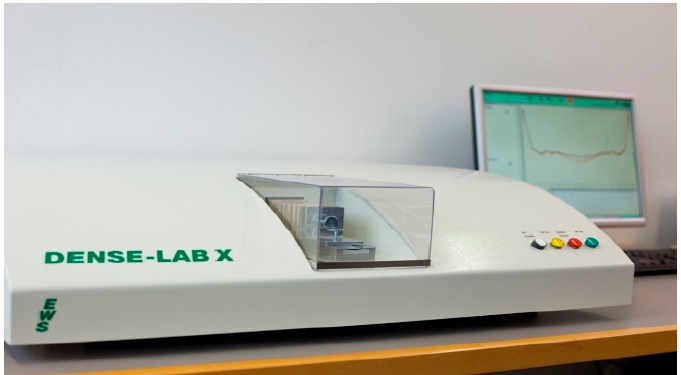
Figure 5. X-ray graph